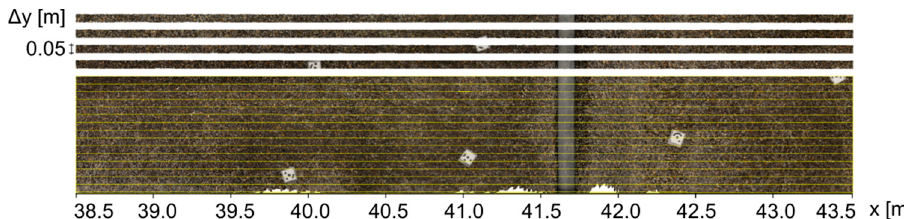
Figure 4. Segmenting of surface data into longitudinal slices of Δ y = 0.05 m wide in preparation for volume comparison.